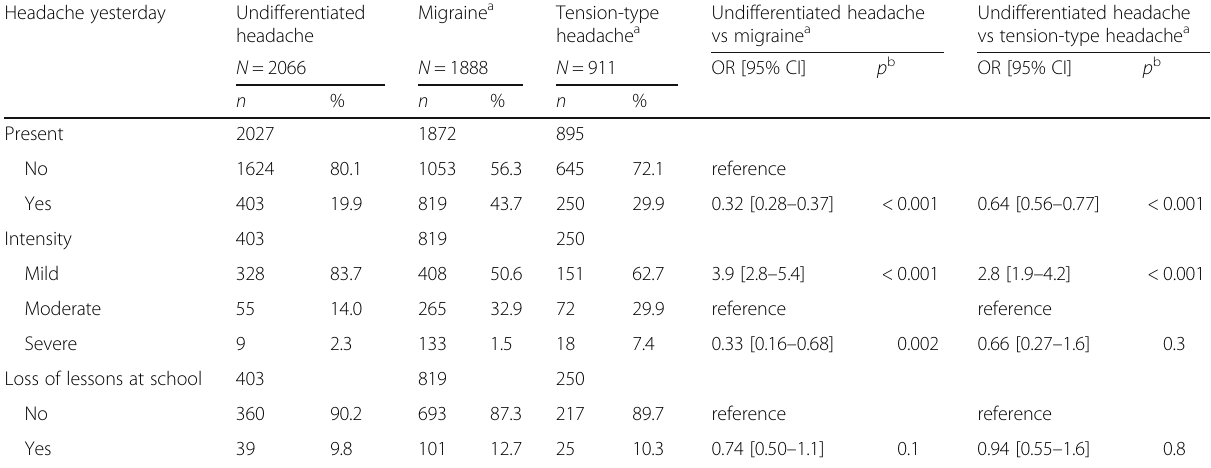
Table 2 Headache yesterday in undifferentiated headache, migraine and tension-type headache Headache yesterday